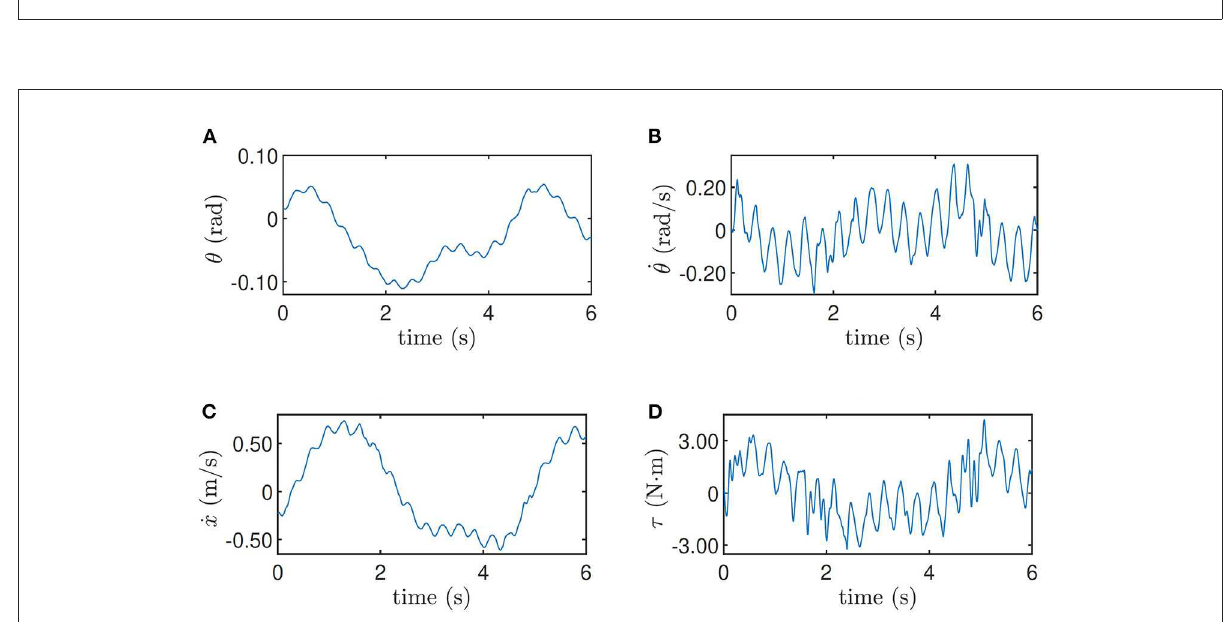
FIGURE4 Images during the training. Many more maneuvers in action and experimental data are shown in the accompanying video. (A) Height = 0.33 m, (B) height = 0.5 m, (C) height = 0.5 m with the load, and (D) height = 0.5 m on the slope.